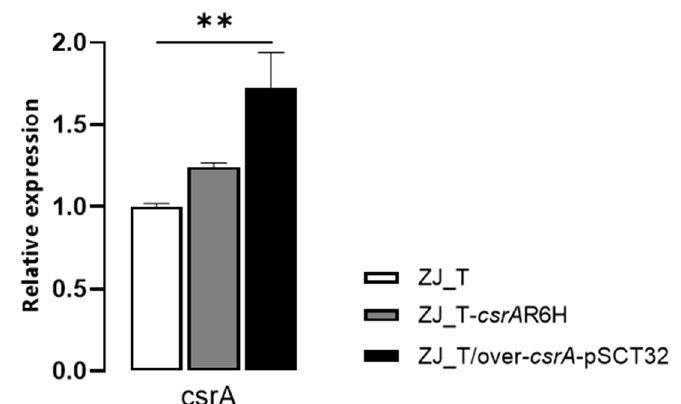
Figure 1. The csrA mutant did not affect transcription. The relative expression of csrA behaved at the wildtype level in terms of expression in the csrA mutant, while it was upregulated in the overexpression strain (One-way ANOVA, FDR ** p < 0.01). The levels of csrA were normalized to the internal control recA level. Error bars indicate standard deviations.